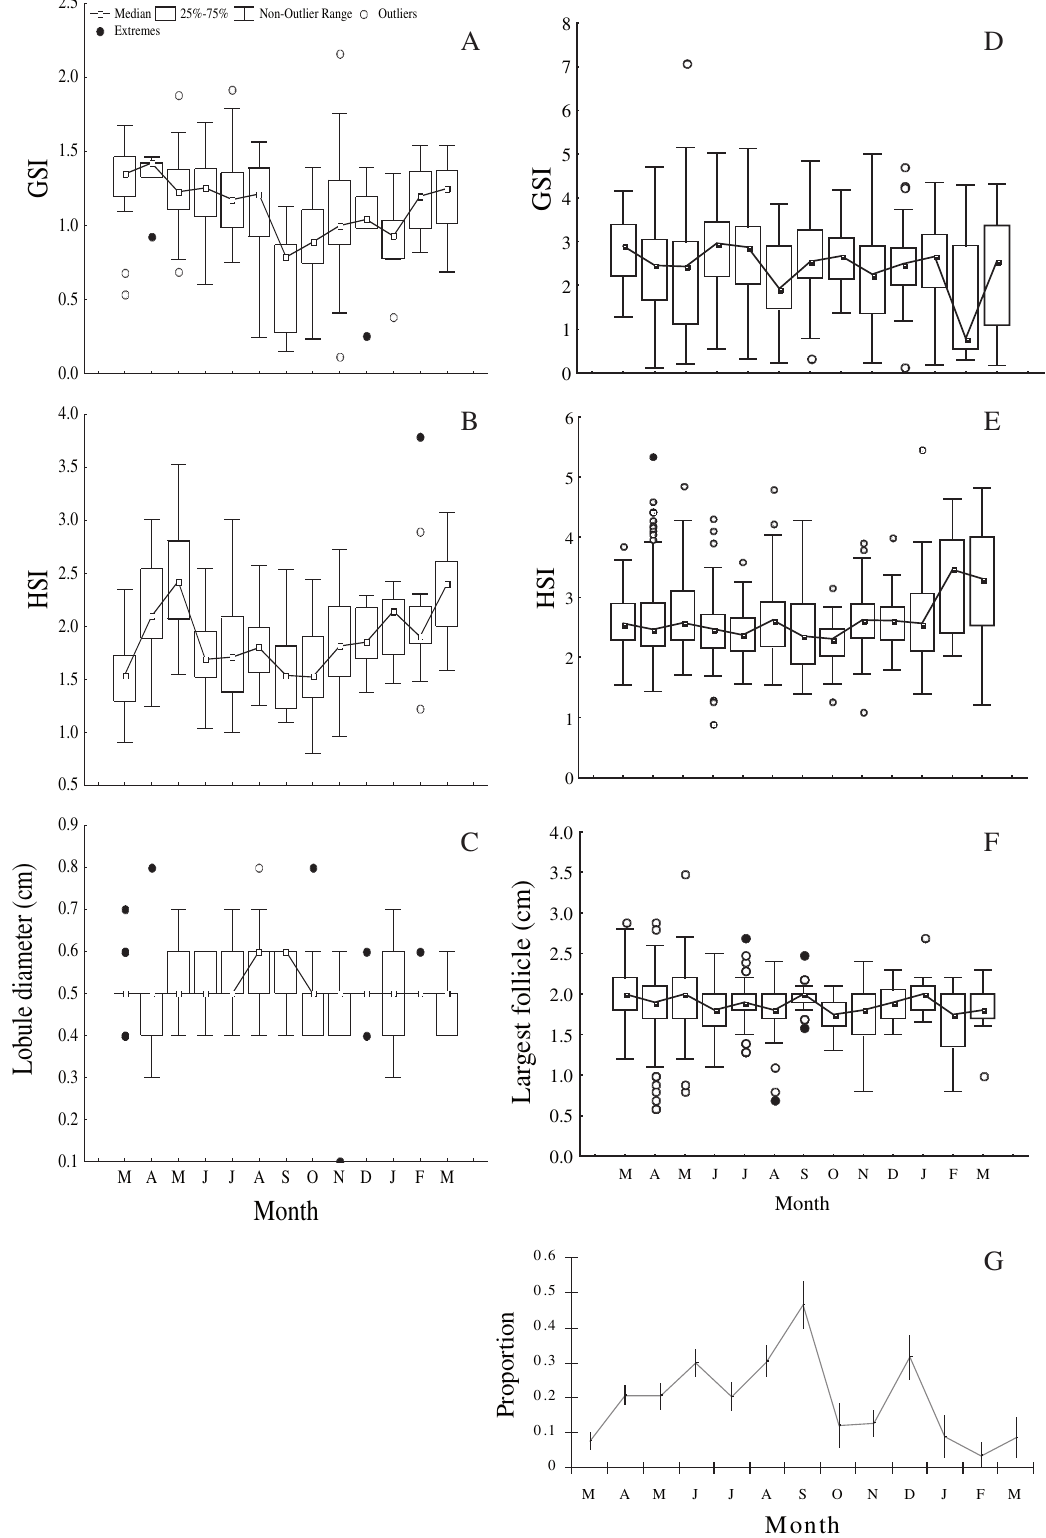
monthly largest follicle diameter (cm) for females; G, monthly proportion of egg-bearing females, from March 2005 to March